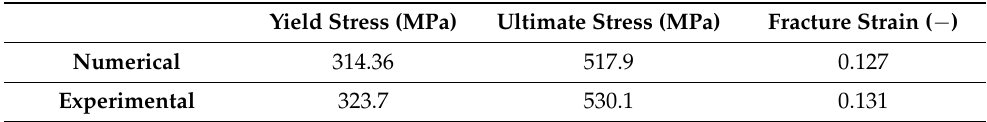
Table 4. Comparison of mechanical behavior and experimental results.